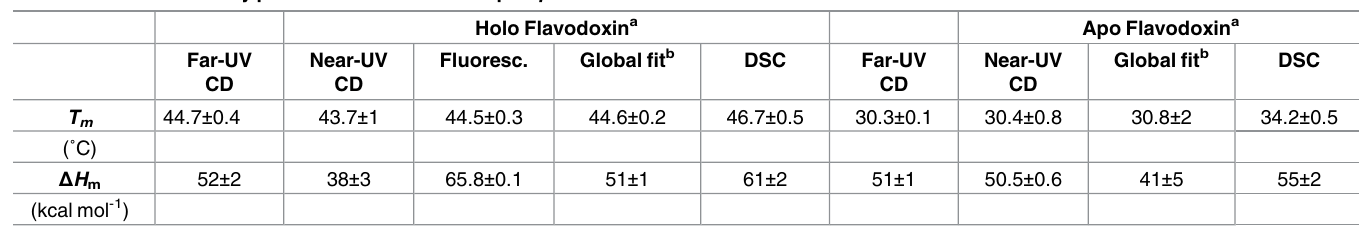
Table 1. Thermal stability parameters for holo and apo Sp